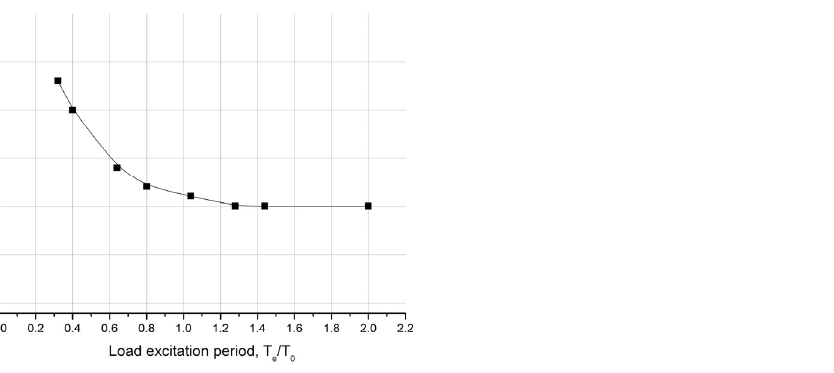
17 of 20 Table 6. Comparison of dynamic ultimate moment of box girder with various density. Model